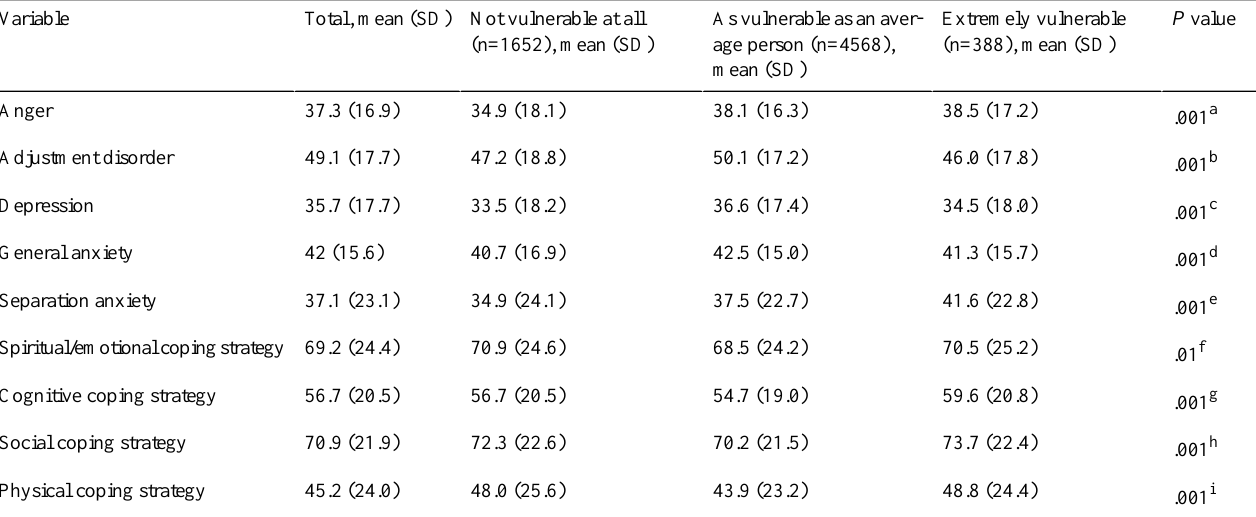
Table 7. The difference in the mean score of selected final psychological diagnoses and coping strategies used between the 3 perceived levels of vulnerability to the coronavirus among children and adolescents during home isolation and social distancing due to the COVID-19 pandemic in Qatar in 2020